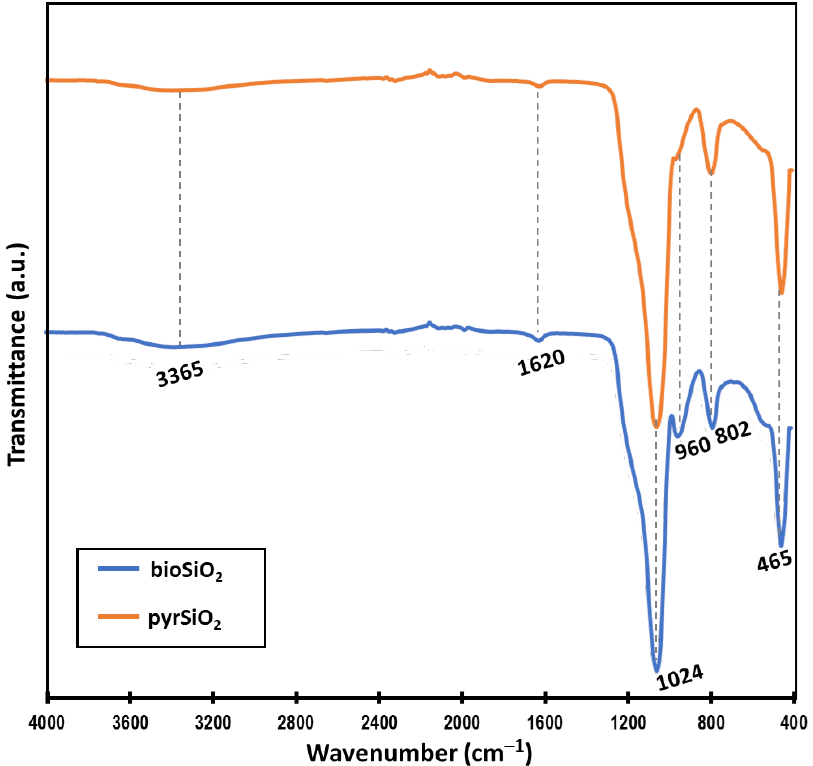
Figure 2. ATR-FTIR spectra of biogenic silica nanoparticles ( bio SiO 2 blue line) and standard silica ( pyr SiO 2 orange line). Strong similarity of both spectra indicates the effectiveness of the biogenic silica isolation method.